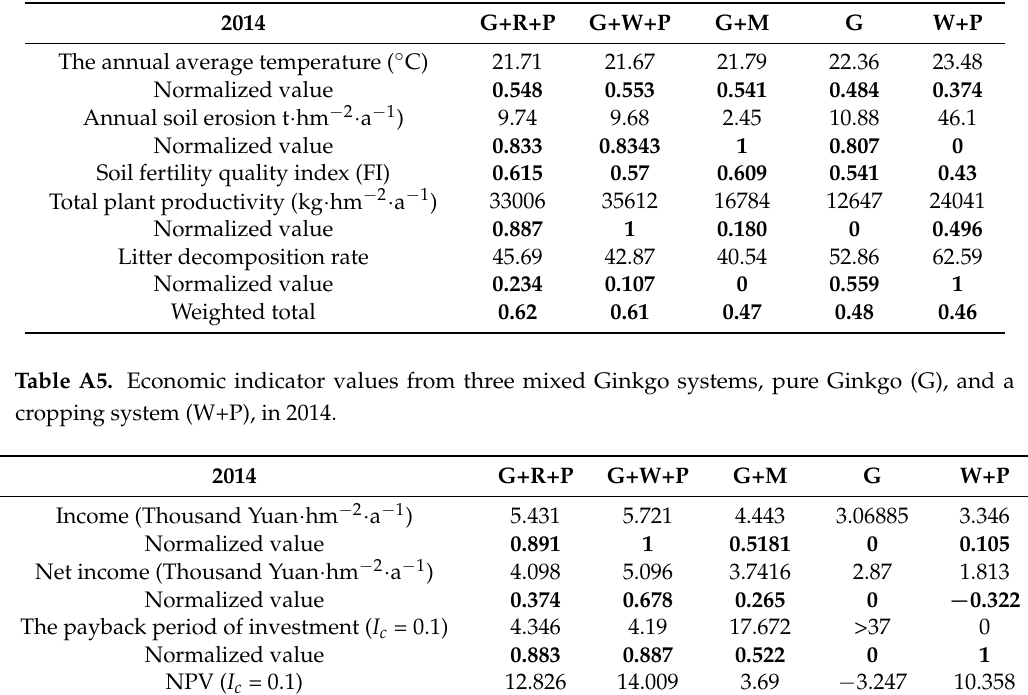
The payback period of investment ( I c =